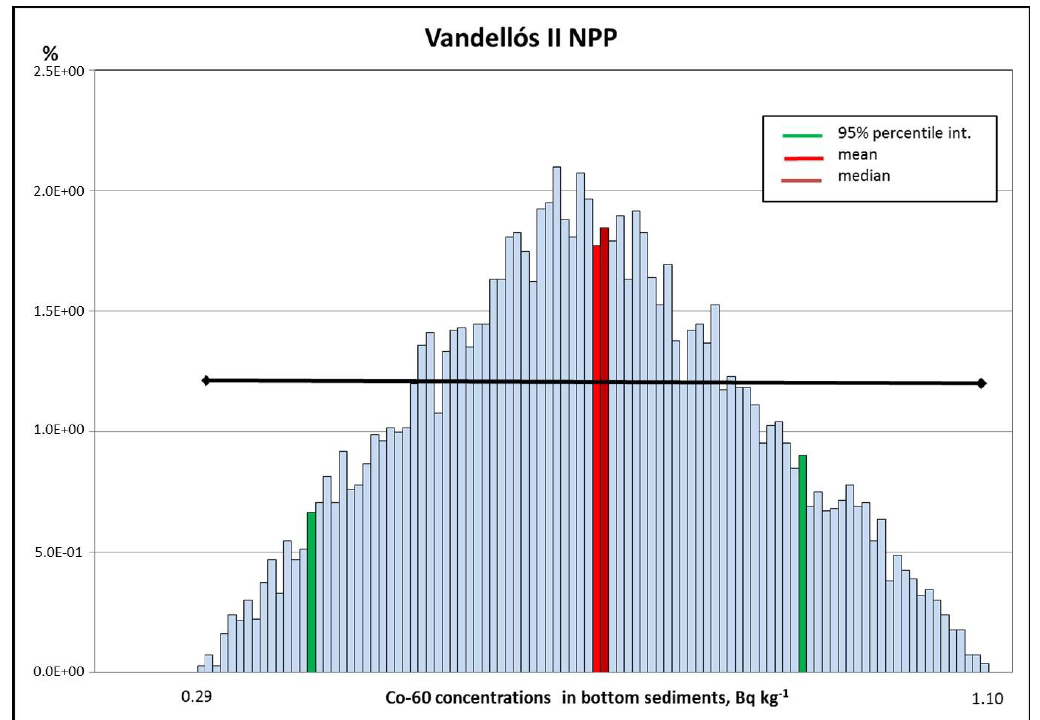
Figure 2. Co-60 concentrations calculated in bottom sediments (Bq kg − 1 ) at the coastal line (Vandellos II). Black segment shows the range of the published measurements.